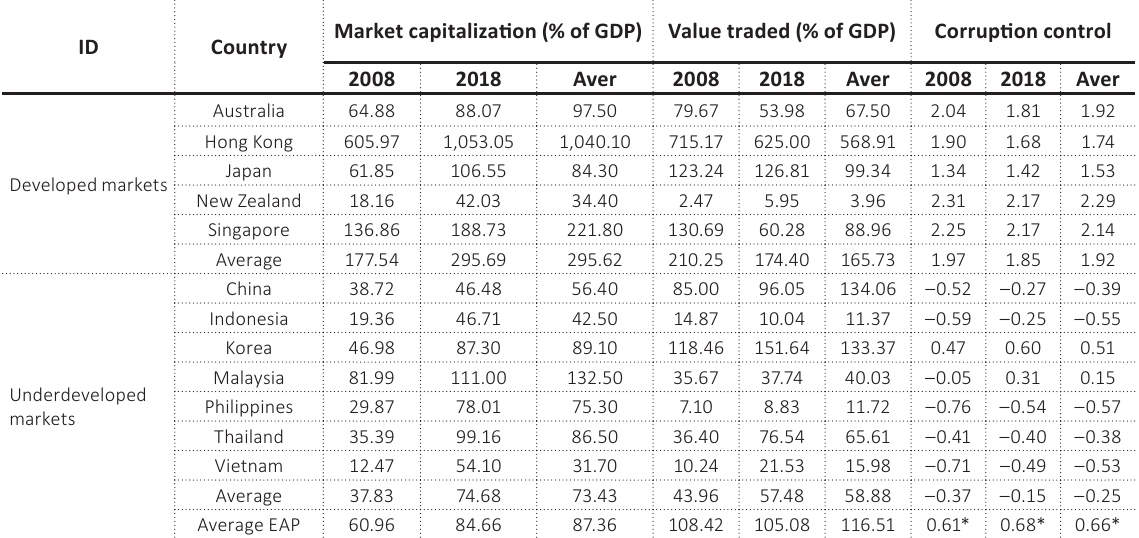
Table 1. Corruption control and stock market development at EAP (2008–2018) Source: World Development Indicators, Worldwide Governance Indicators, and author